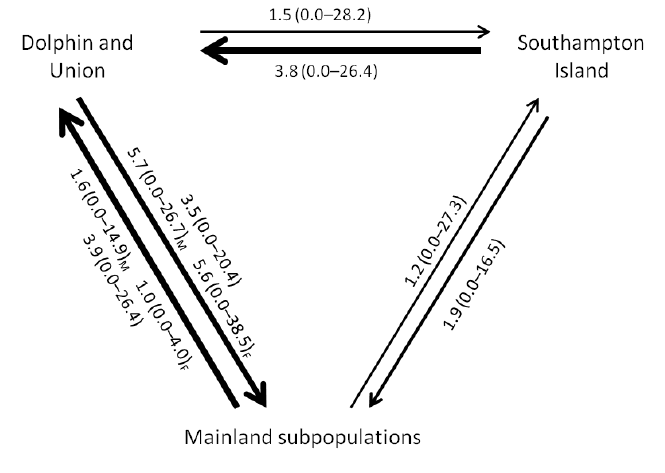
Figure 4. Historical gene flow estimates (N m) between the mainland and island subpopulations. 95% e credibility intervals are indicated in parentheses. Arrow thickness is scaled according to values. Values reflect estimated number of migrants per generation among all migratory barren-ground caribou, unless indicated by the subscripts “M” (male-only data) or “F” (female-only data). Mainland subpopulations include BE, BAT, QAM and BEV/AH for estimates based on the entire dataset and the female-only data; for the male-only data, mainland subpopulations include BE and QAM. Estimates into and out of South- ampton Island include both males and females, as no sex information was available for SH.